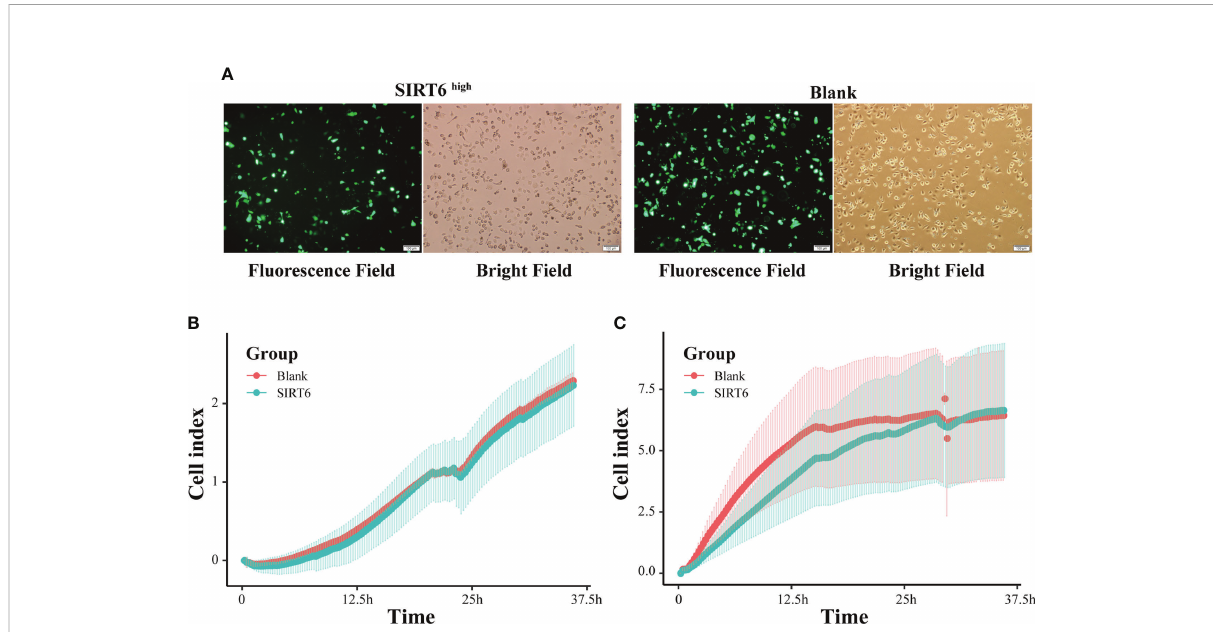
FIGURE 8 SIRT6 overexpression inhibited GC cell proliferation. (A) AGS cells were examined by light microscopy and fl uorescence microscopy 24 h after transfection with SIRT6 overexpression vector or blank vector. (B) Line chart showing AGS cells ’ real-time migration in 36 h with cell index by RTCA assays. (C) Line chart showing AGS cells ’ real-time proliferation in 36 h with cell index by RTCA